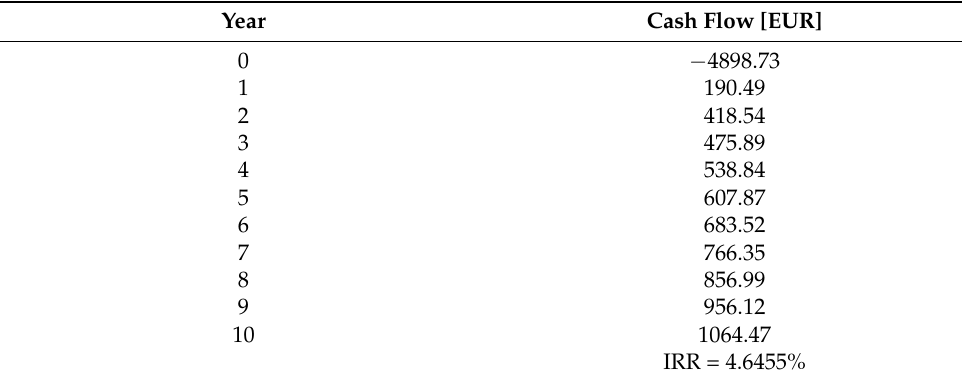
Table 4. Cash flows for investments in a heat